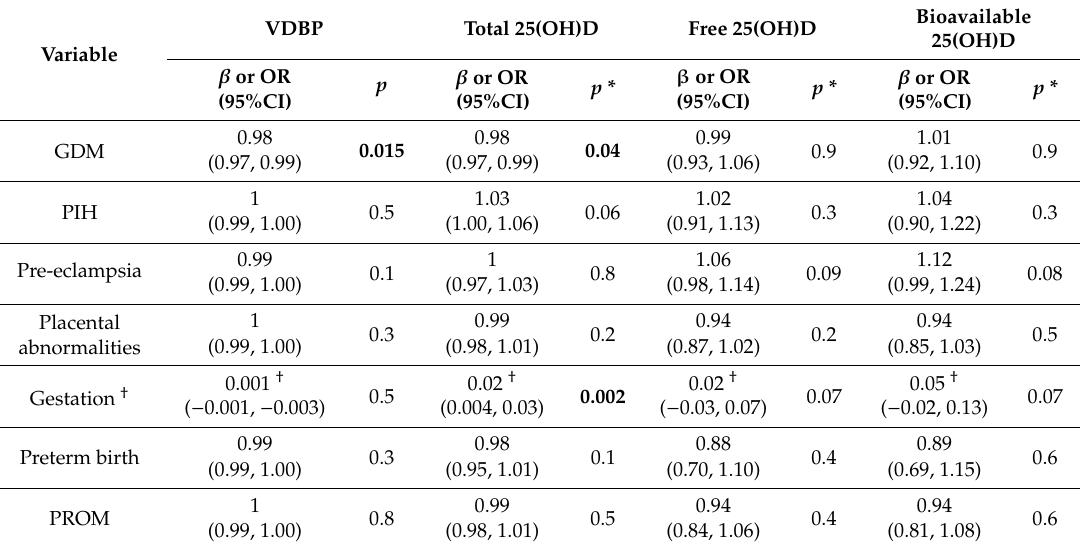
Table 5. Univariable associations between vitamin D metabolites and maternal outcomes.